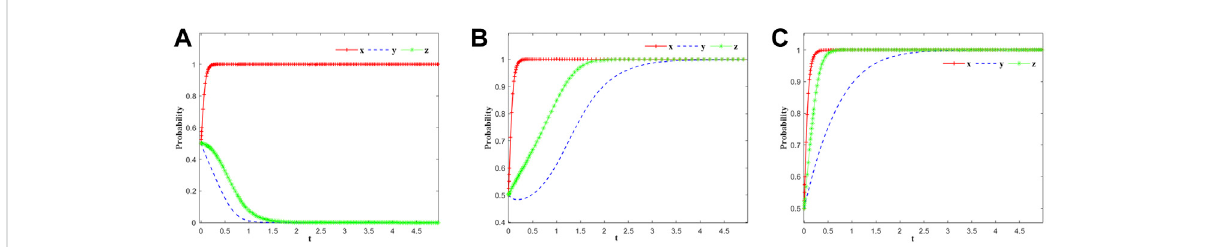
FIGURE 5 Simulation of the evolutionary strategy of the three parties under different penalties imposed by local governments on enterprises. Note: t denotes thetime, i.e., thespeed of achieving low-carbon treatment, and F 2 = 3, 8, 15 inPanel 5 (A – C) , respectively, denotethe penalties imposedby the local government on the enterprises from small to large.